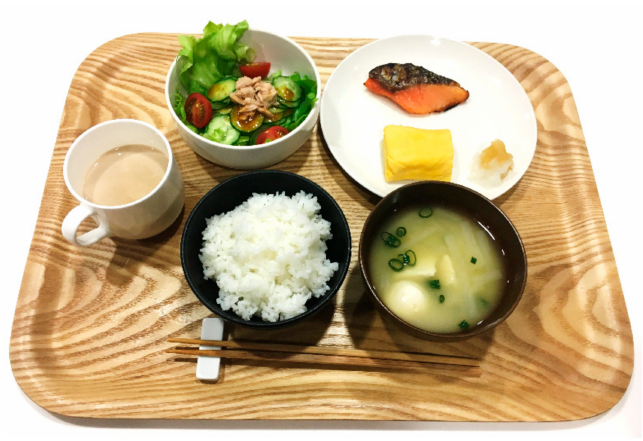
Figure 2. Test mixed